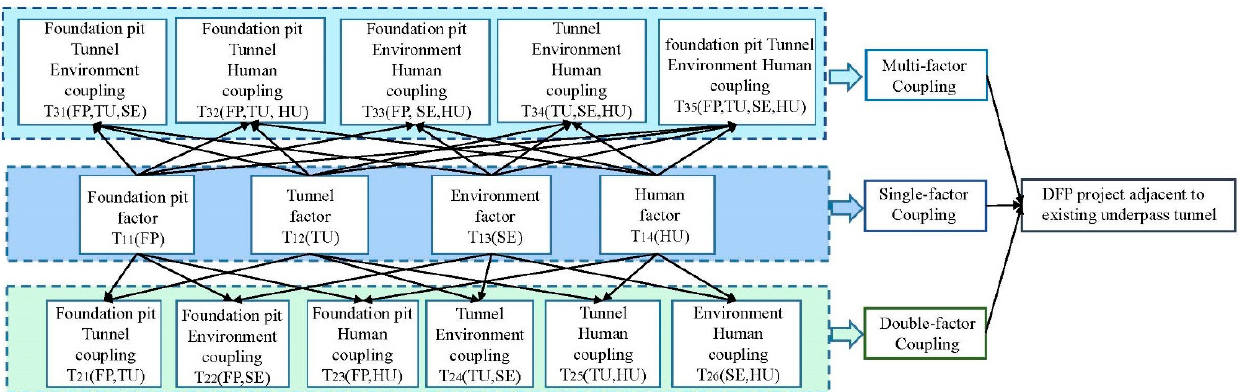
Figure 3. Construction accident risk coupling mechanism of DFP adjacent to the existing underpass tunnel.